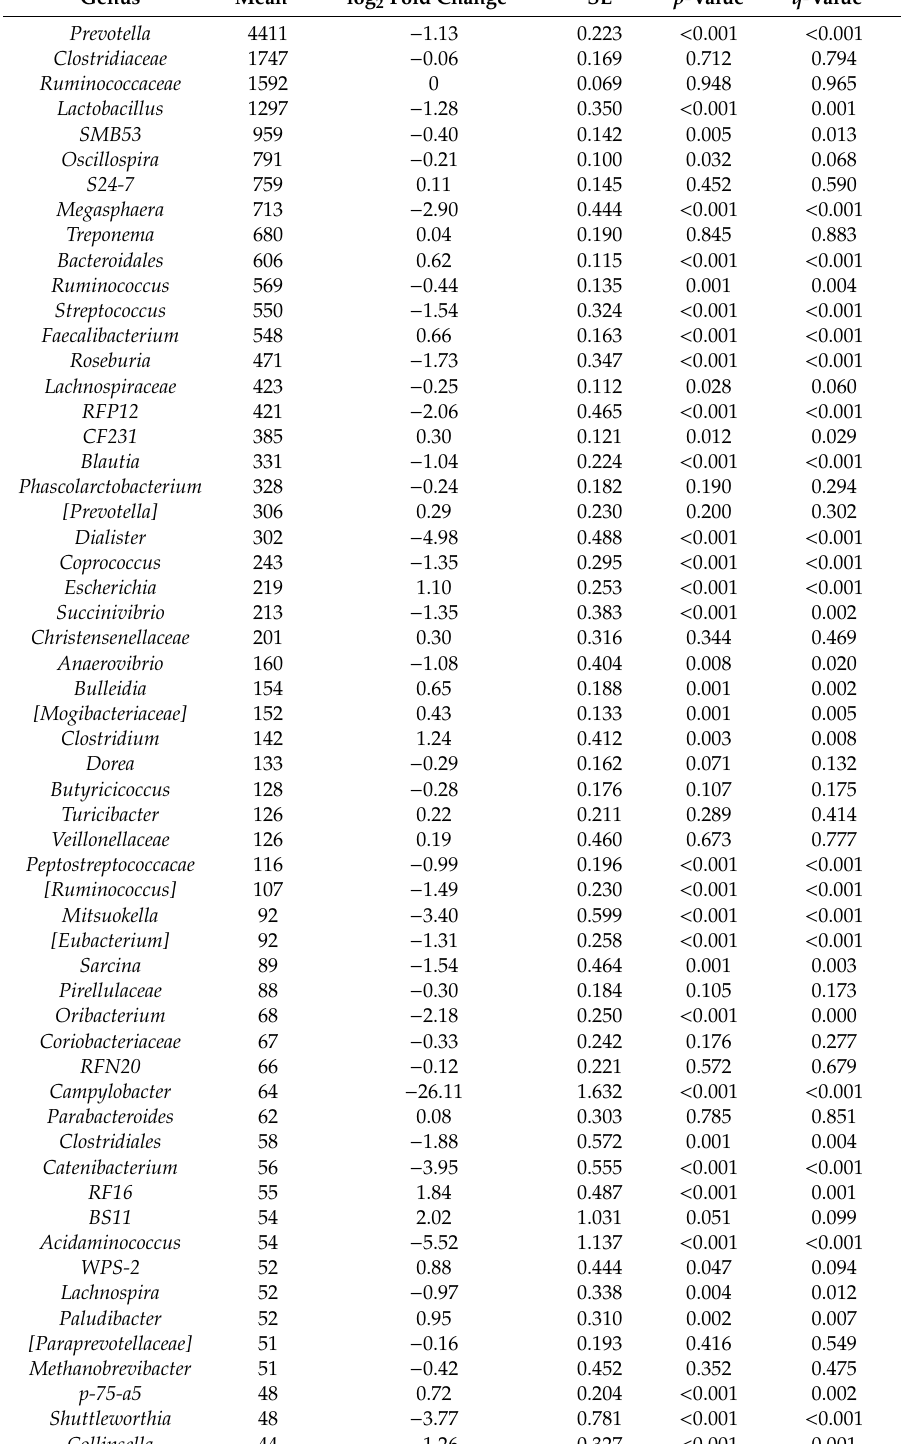
Table 6. Di ff erences in selected genera (hit counts) between the two fecal ‘community type’ clusters in